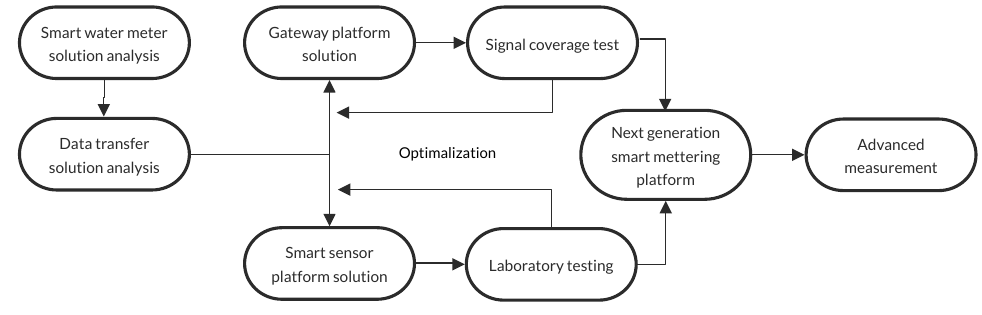
Figure 2. Smart water meter